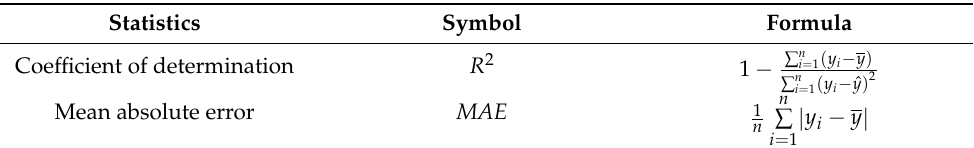
Table 1. Regression evaluation